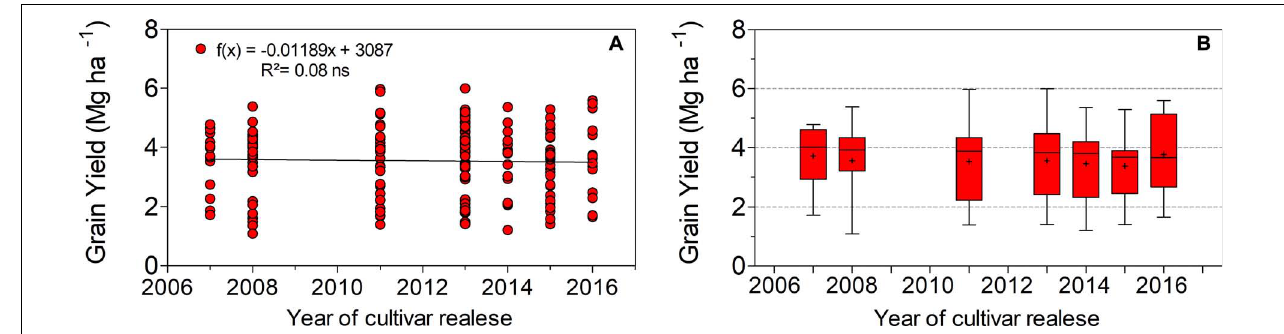
FIGURE 1 | (A) Relationship between the years of varieties’ releases and yield, and (B) box plot diagrams of yield indicating the variability outside the upper and lower quartiles across years ( n = 192).